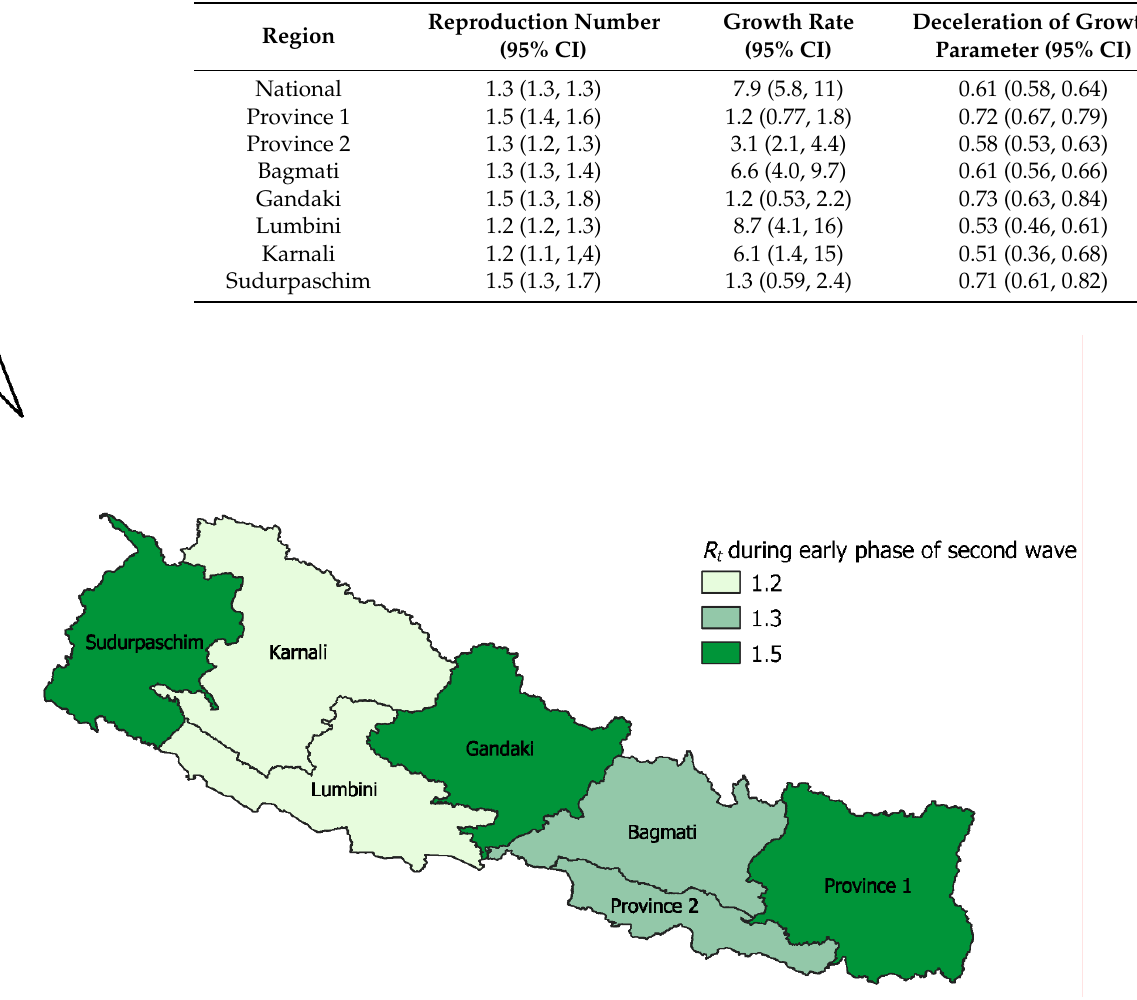
Figure 10. Map showing reproduction number at province level, for first 30 days of the second wave (12 April – 11 May